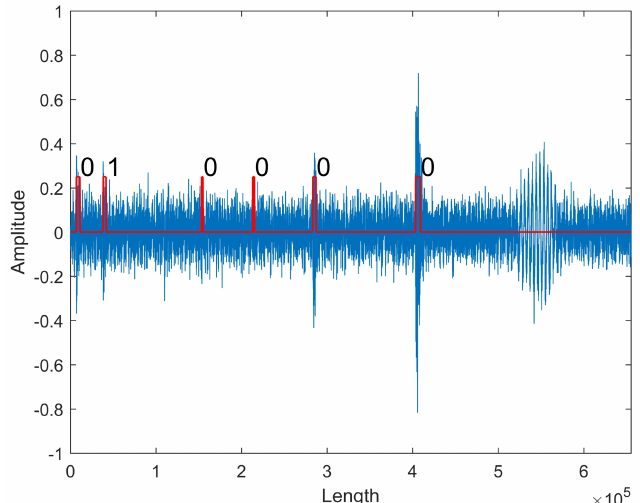
Figure 8. The recognition on original data. The rectangular pulses in red show the positions of pulse sound signals extracted by the intelligent monitoring network. The fault signal is denoted with 1, and the normal signal is denoted with